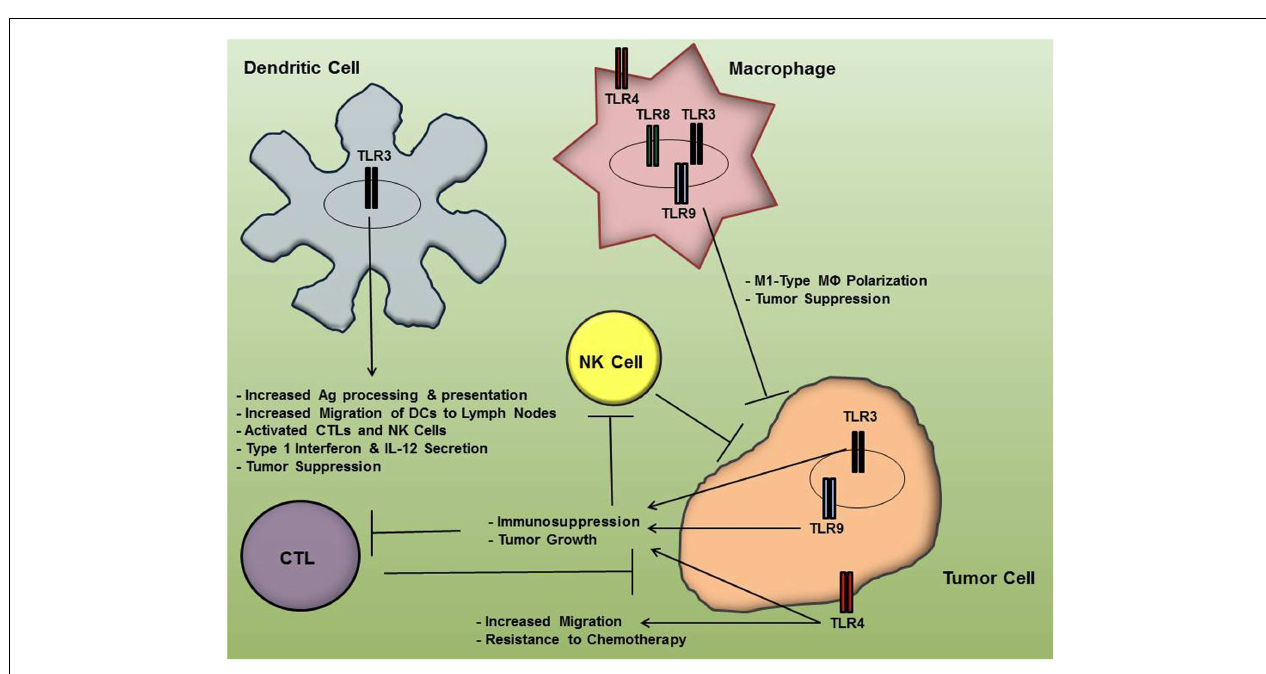
microenvironment, their signaling pathways in tumor cells may result in immunosuppression and resistance to chemotherapy, thereby furthering tumor